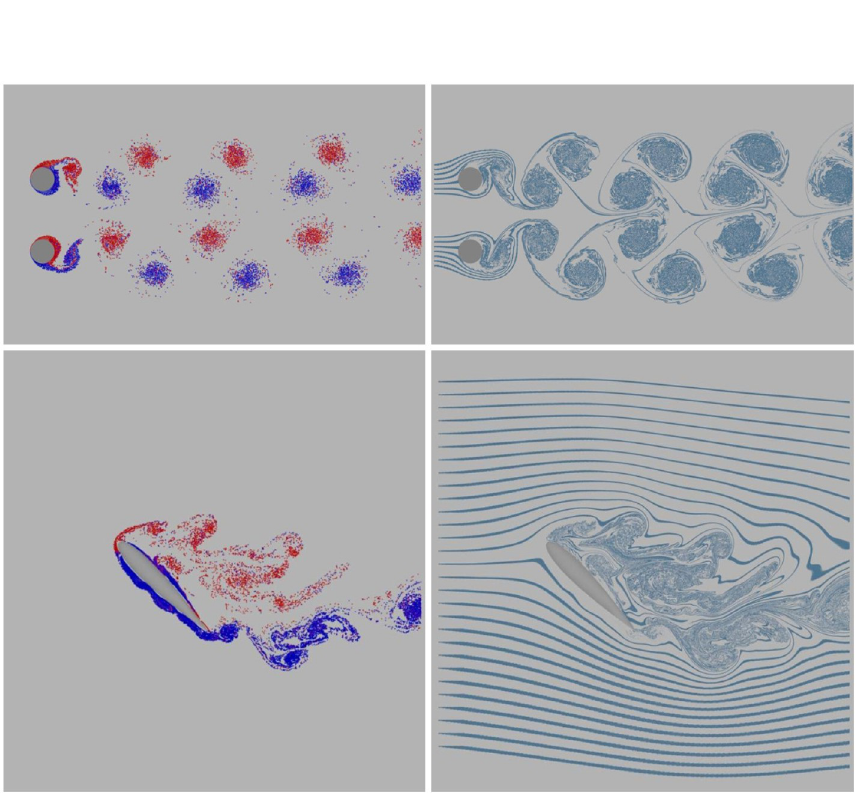
Fig 10. 2D boundary treatment results. The first row presents Ka ´ rma ´ n Vortex Street behind two discs; the second row displays vortex shedding behind an airfoil. Blue and red represent the vortex particles with negative and positive vorticity, respectively. Mineral blue represents the tracer